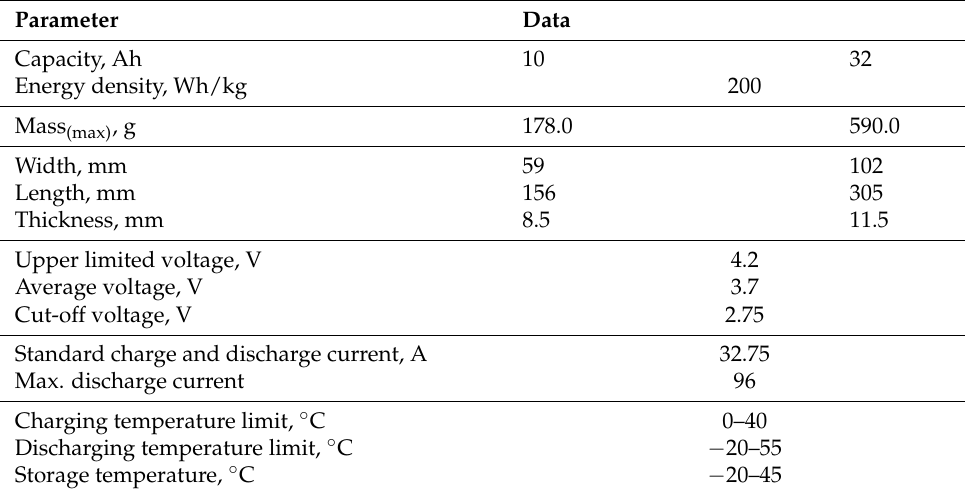
Table 5. Cell parameters provided by